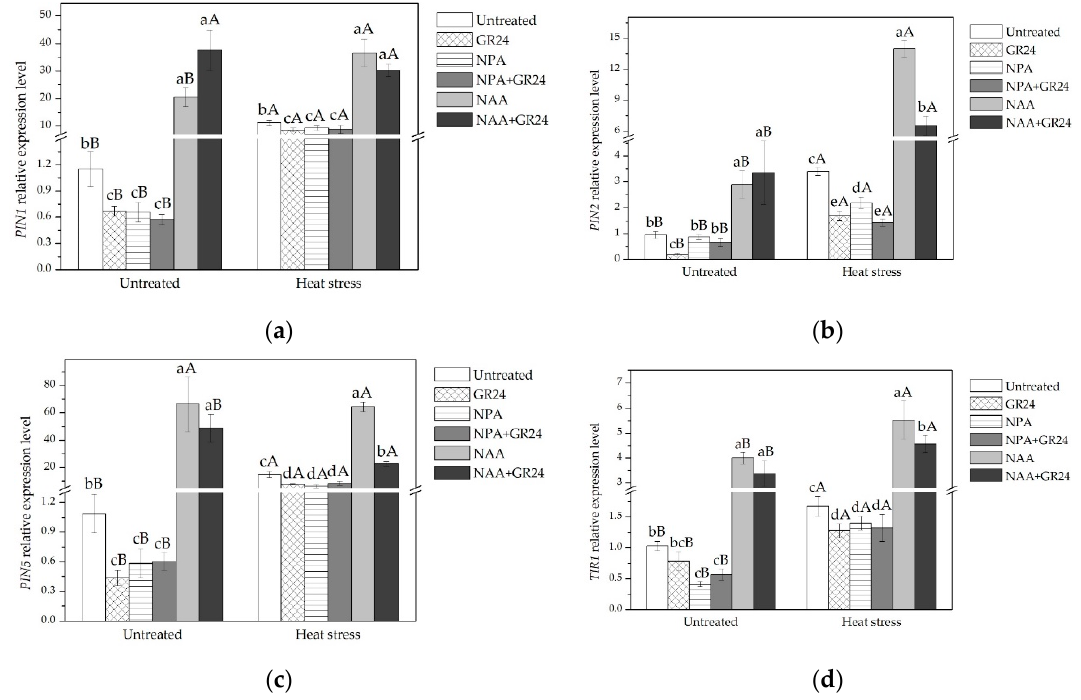
Figure 4. ( a ) TIR1 expression level in leaves for all treatments; ( b ) PIN2 expression level in leaves for all treatments; ( c ) PIN5 expression level in leaves for all treatments; ( d ) PIN1 expression level in leaves for all treatments. Lowercase letters are for comparison between different chemical treatments, and uppercase letters are for comparison between treatments under two temperature conditions.